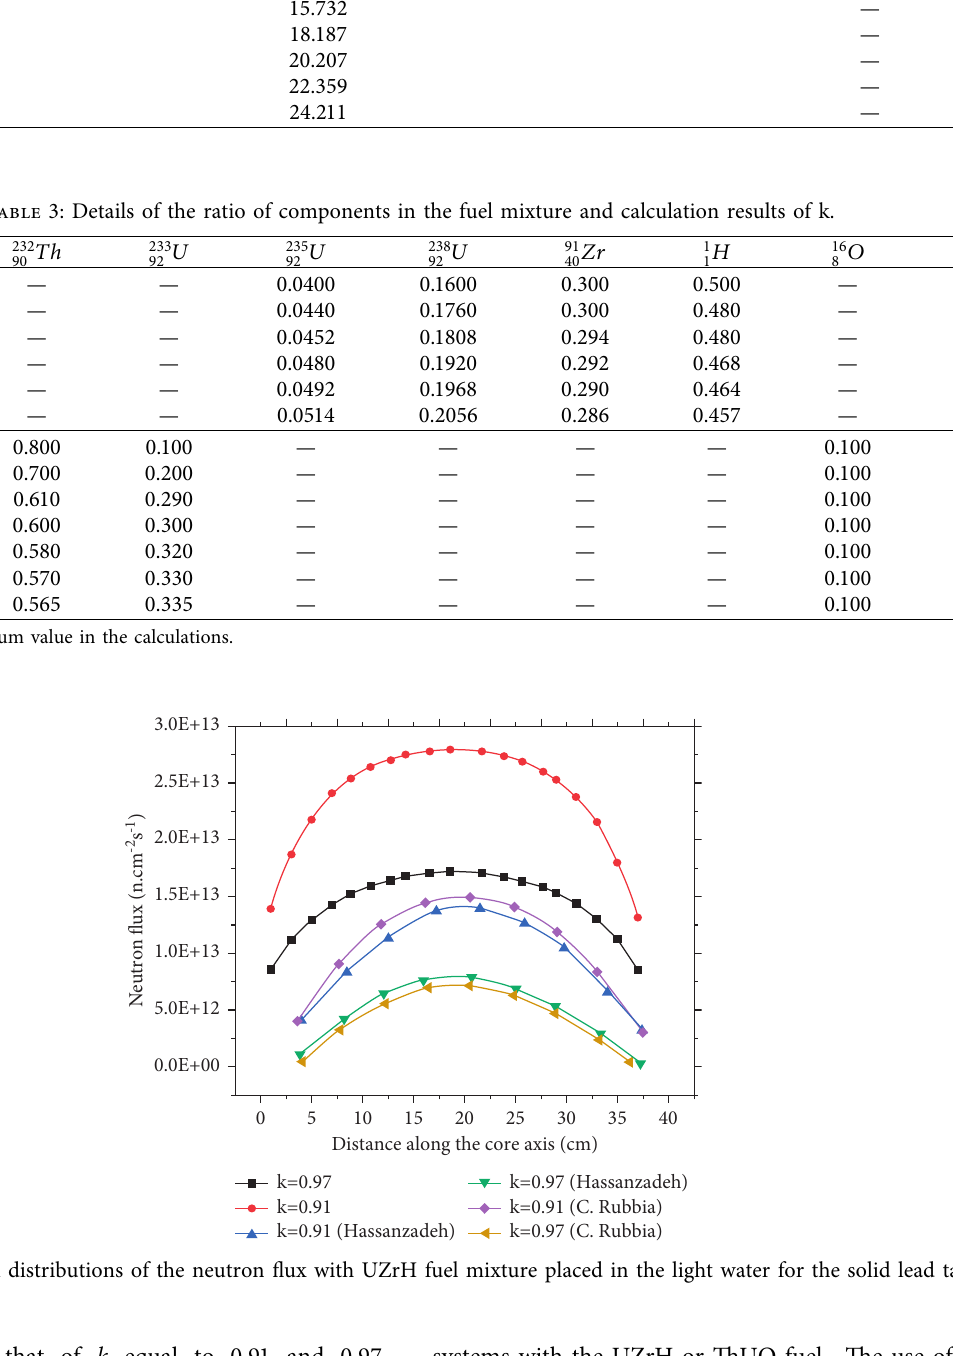
Table 2: The neutron yields for two targets (solid and molten lead) used. Energy (MeV)